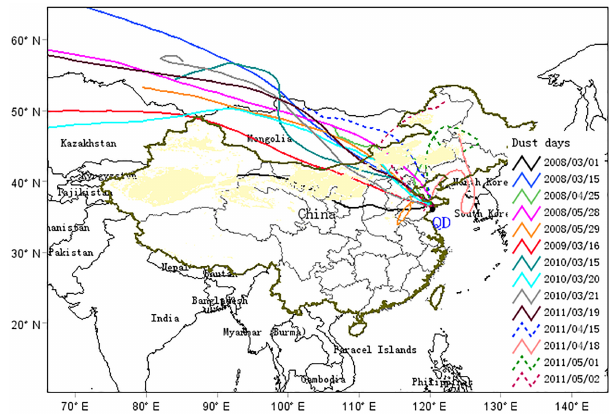
Figure 5. The 72h backward trajectories for dust samples from 2008 to 2011 (the yellow domains in the map represent the dust source regions in